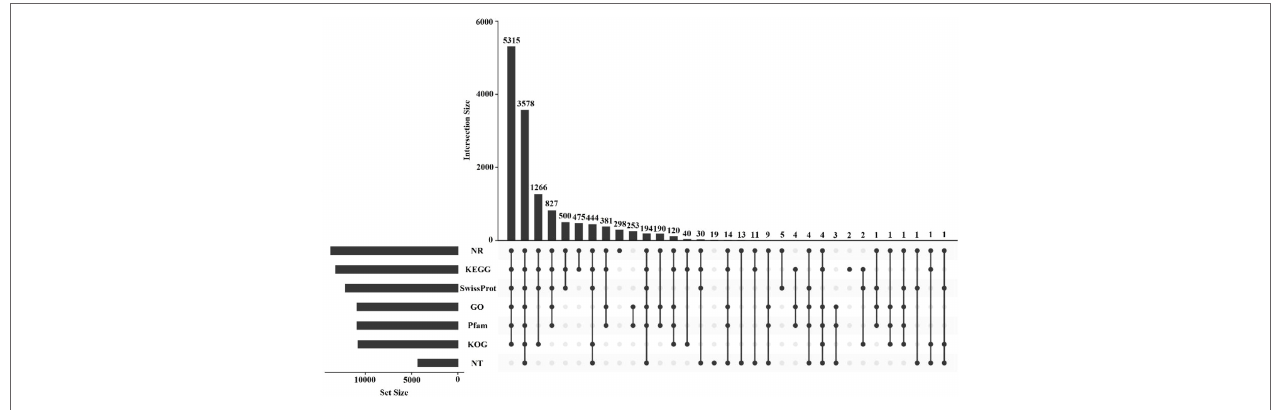
FIGURE 3 | UpSet plot showing the results of the annotated transcripts and the number of unique annotated transcripts for each